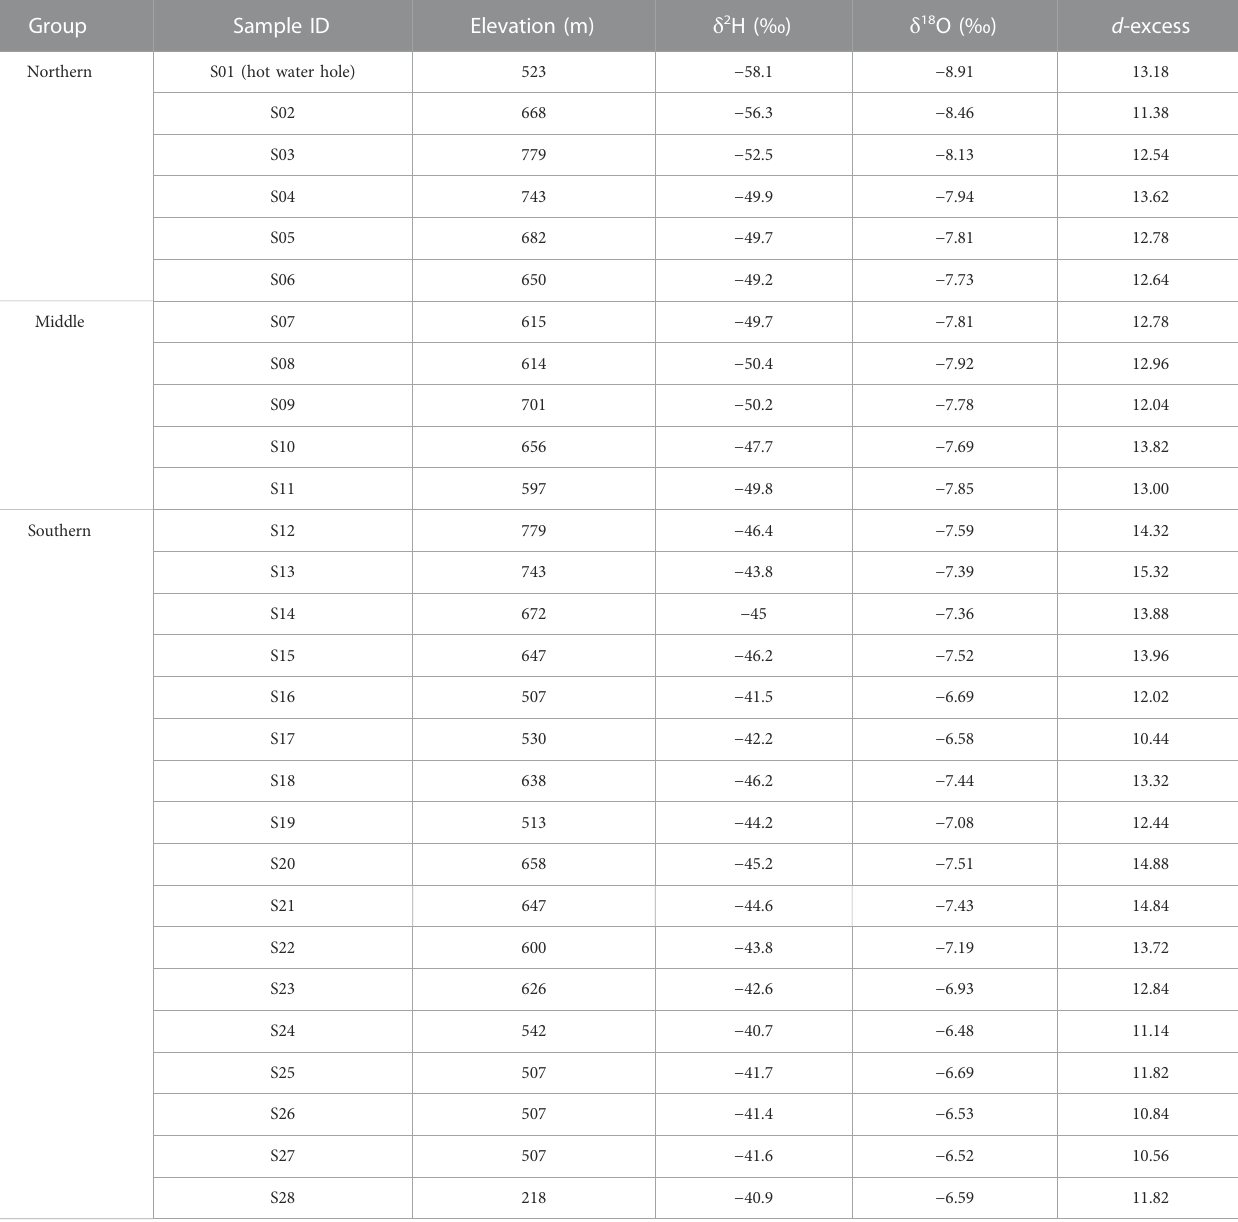
TABLE 2 δ 2 H and δ 18 O isotope information of water samples. Group Sample